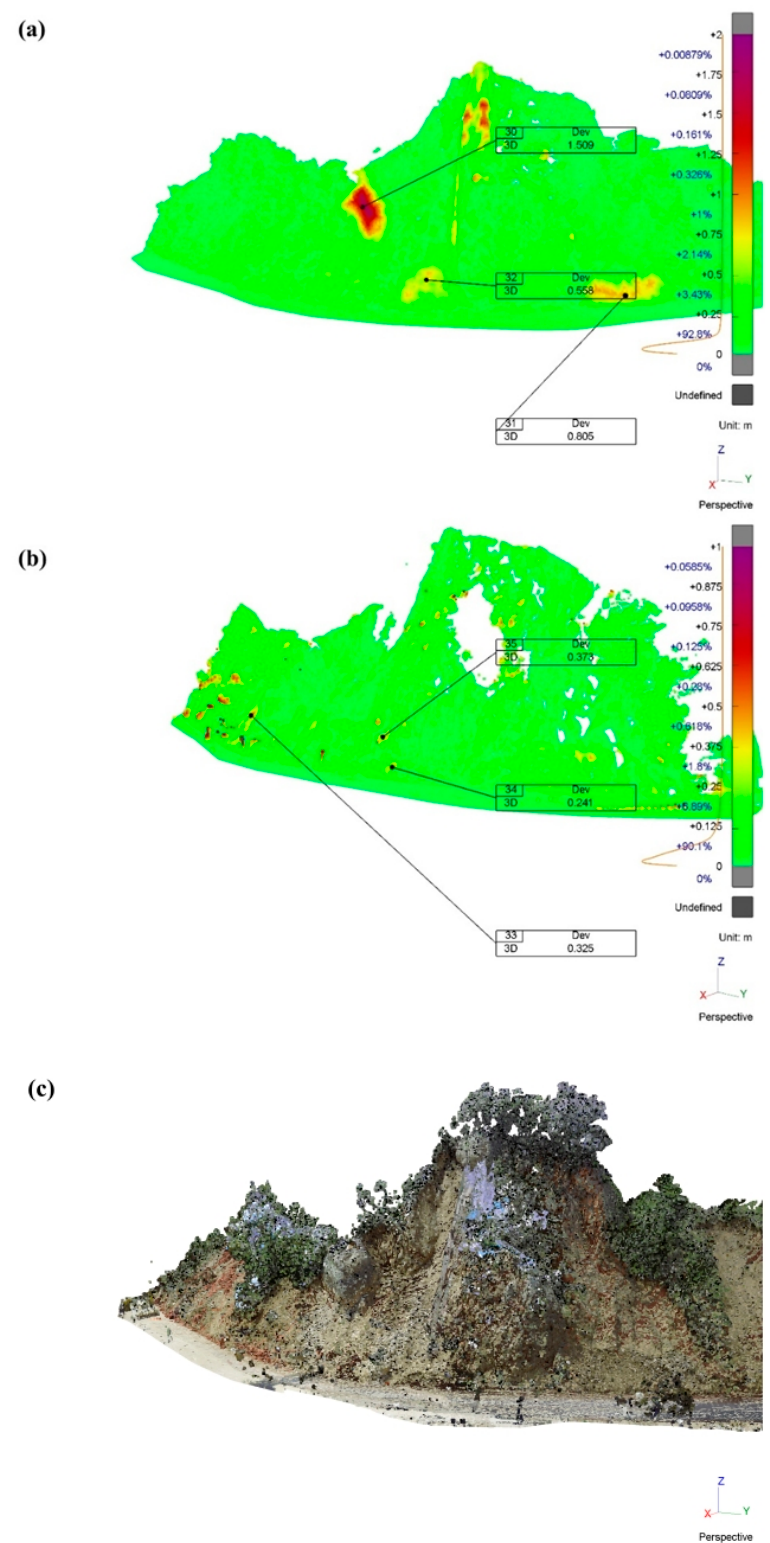
Figure 12. ( a ) Cloud-to-cloud comparison between the TLS point clouds acquired on 10 June 2020 and 25 September 2020. ( b ) Cloud-to-cloud comparison between the TLS point clouds, acquired on 25 September 2020 and 7 November 2021. ( c ) TLS point cloud acquired on 10 June 2020 in RGB.